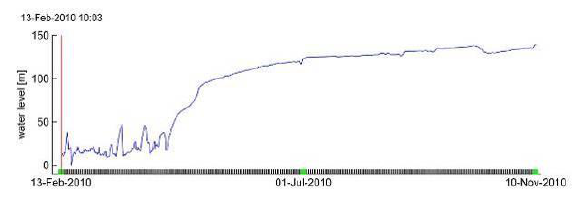
Figure 14. Water level variations at Lago Cachet II 27.11.2009 - 10.2.2010